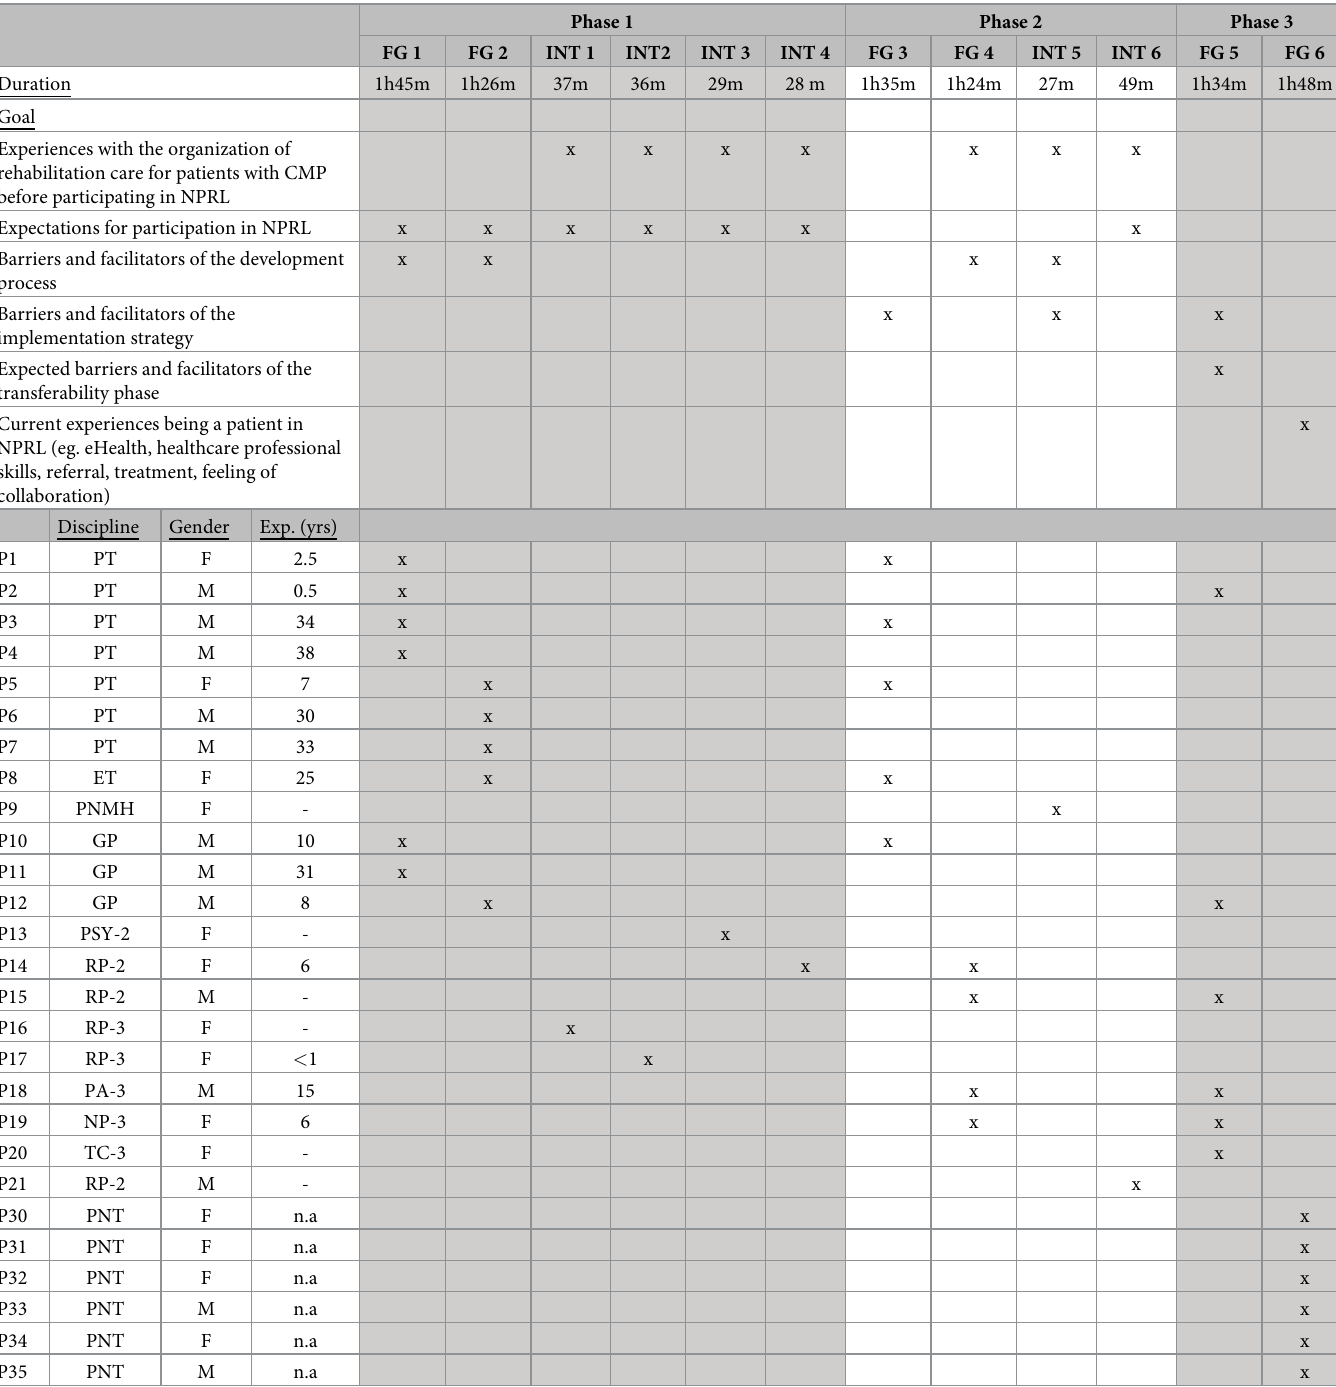
Table 1. Description of the content, duration, and discipline involved for the focus groups and